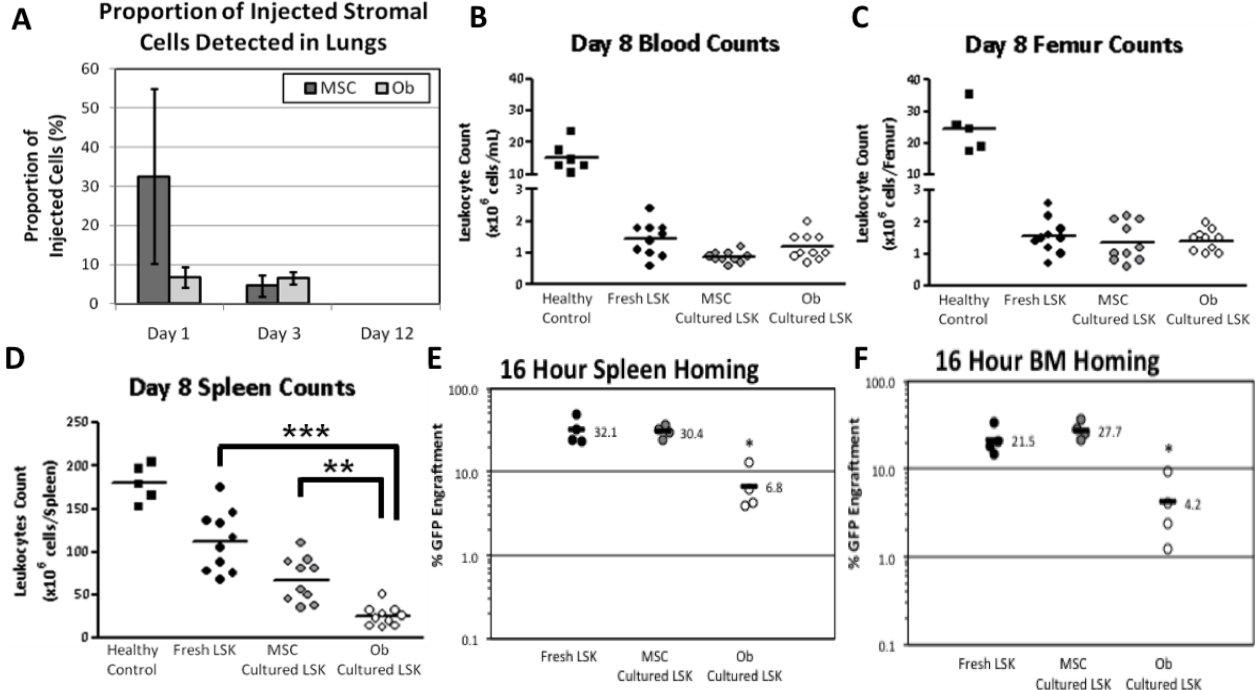
Figure 4. Early post-transplant migratory studies of MSC, osteoblasts and cultured LSKs. ( A ) GFP + MSCs and osteoblasts were detected in the lungs by qPCR for GFP on days 1 and 3 but not on day 12 after primary transplantation ( n = 4 per time-point). Co-cultured donor GFP + leucocytes were detected in the ( B ) blood, ( C ) BM and ( D ) spleen at eight days post-transplant ( n = 4 per group). Leucocyte counts in the spleen 8 days after primary transplantation showed a significant decrease in splenic leucocytes in the osteoblast co-culture group ( p = 0.0084) compared to recipients of fresh LSK or recipients of marrow co-cultured with undifferentiated MSCs ( n = 10 per experimental group pooled from 3 independent experiments; healthy controls n = 5–6). At 16 h postransplant, significantly less donor GFP + haematopoietic cell homing was detected in recipients of osteoblast co-cultured LSKs in the ( E ) spleen and the ( F ) BM compared to recipients of fresh LSKs and MSC co-cultured LSKs ( * p < 0.05; data presented from 1 transplant with 4 recipients per group). Data represent mean ±